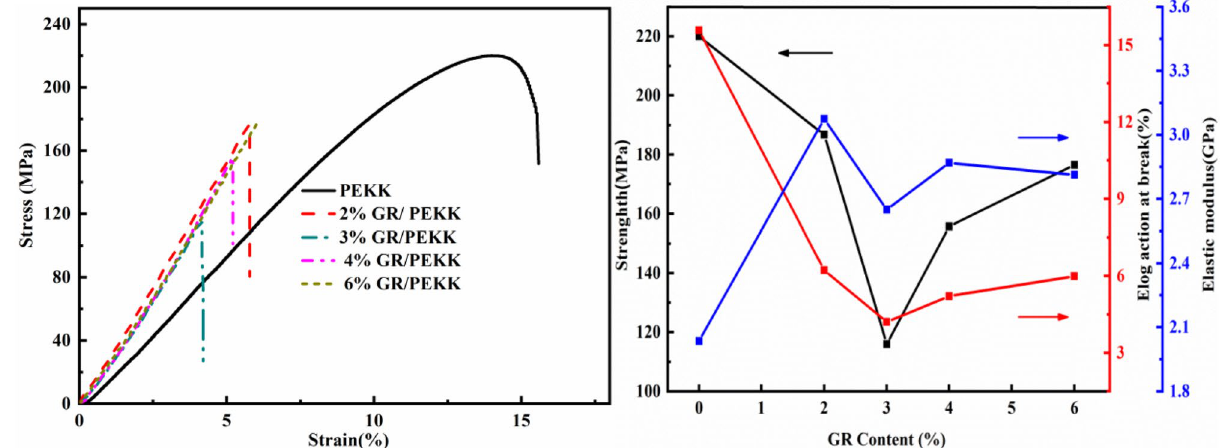
Figure 7. Tensile measurement for PEEK and graphene x /PEEK composites: ( a ) stress–strain curves from uniaxial tensile tests, ( b ) performance of composite materials.